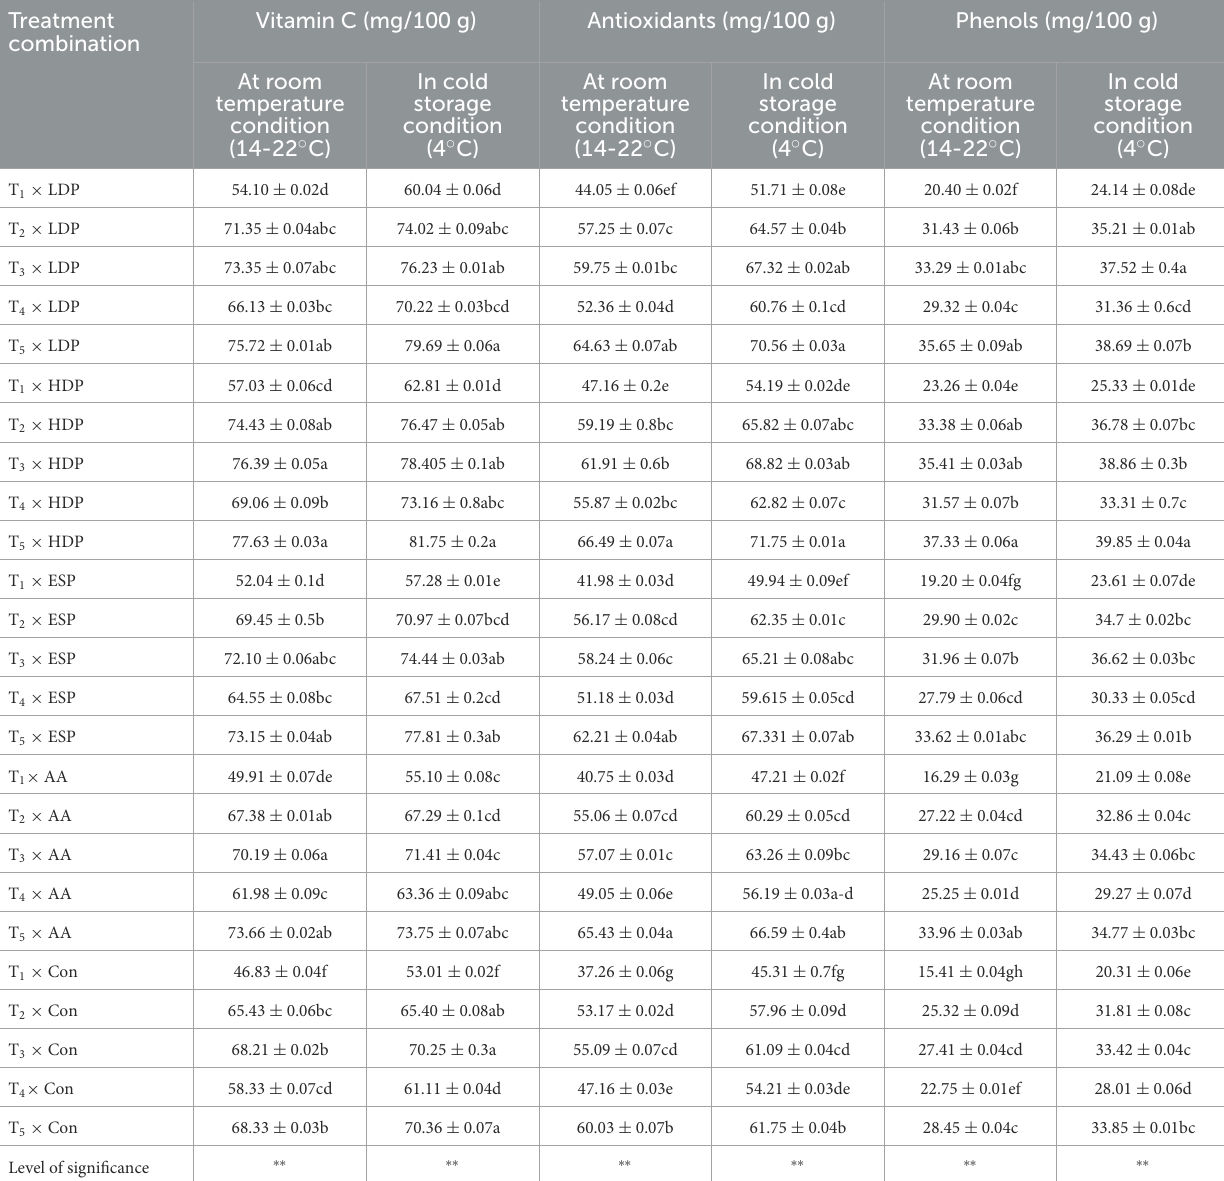
TABLE 7 Effects of pre-harvest foliar application of mineral nutrient sources and post-harvest packaging and chemical treatments on nutrient contents broccoli heads under different storage temperatures at the maximum shelf-life stage. Treatment combination